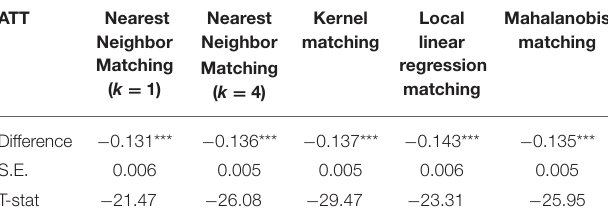
TABLE 3 | PSM analysis of the effects of migration distance on